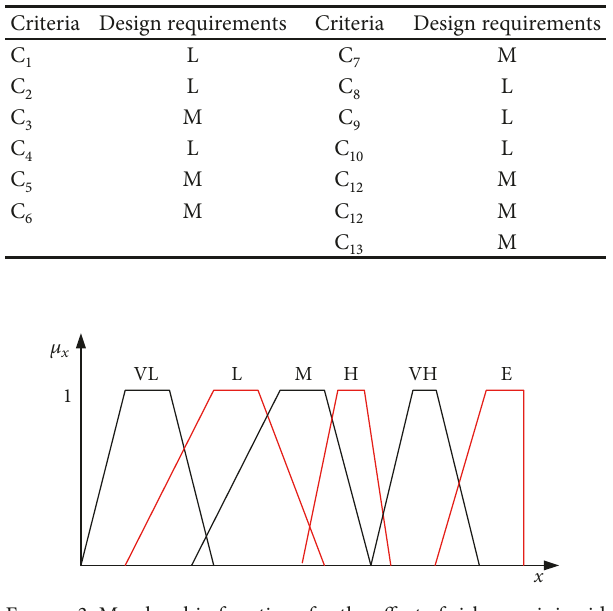
Figure 3: Membership functions for the effect of risk on mini-grid energy sources.